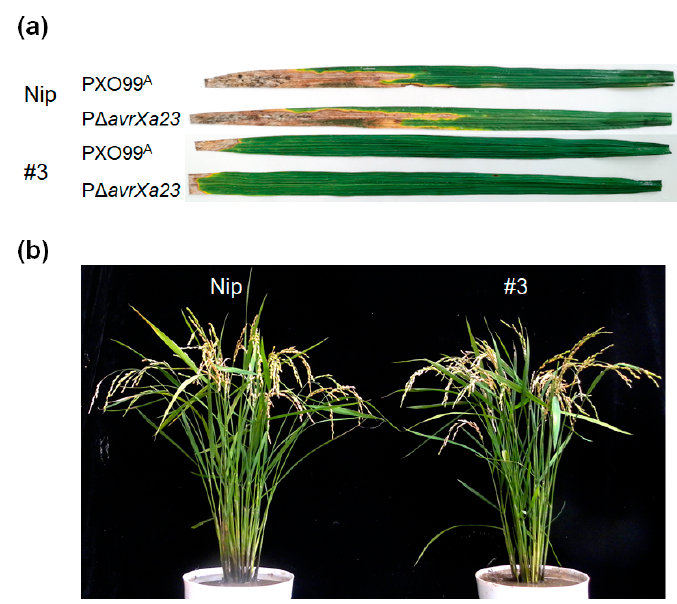
Figure 5. Leaky expression of Xa23 led to over-response of the immune system. ( a ) Disease pheno- types of T 2 plants of line #3 and wild-type Nipponbare (Nip) at tillering stage inoculated with PXO99 A and avrXa23 deletion mutant P Δ avrXa23 by leaf-clipping method at OD600 = 1.0. ( b ) Phenotypes of the T 2 plants of line #3 at mature stage in Sanya field trial.